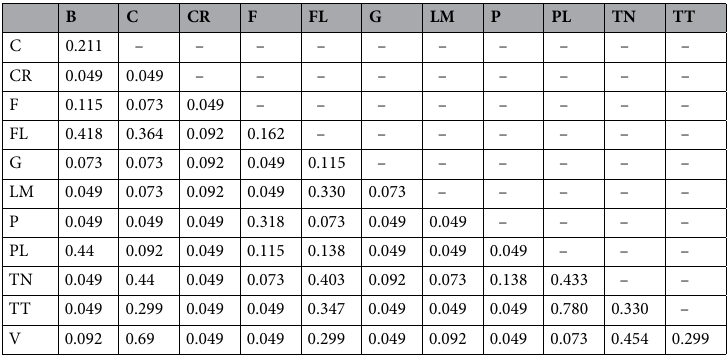
Table 5. Results of MANOVA pairwise comparisons of species communities among sites: Baneasa (B), Pantelimon (P), Grivita (G), Lacul Morii (LM), Fundeni (F), Carol (C), Plumbuita (PL), Tineretului (TN), Titan (TT), Floreasca (FL), Cringasi (CR), Văcăreşti (V). The values represent the p adjusted values after Bonferroni correction, obtained using random permutations.